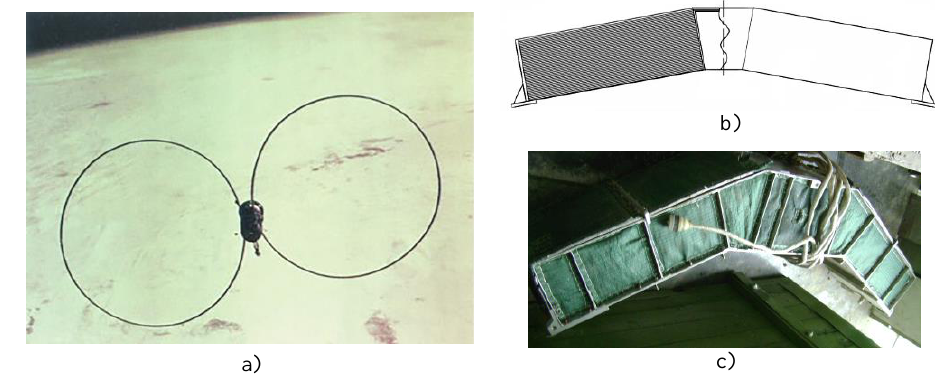
Fig. 1. Transformable space structure: a) spacecraft with two closed load-bearing framework; b) the load-bearing framework put into the container; c) external view of the